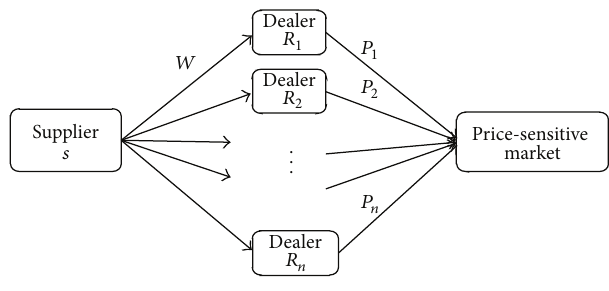
Figure 1: Supply chain